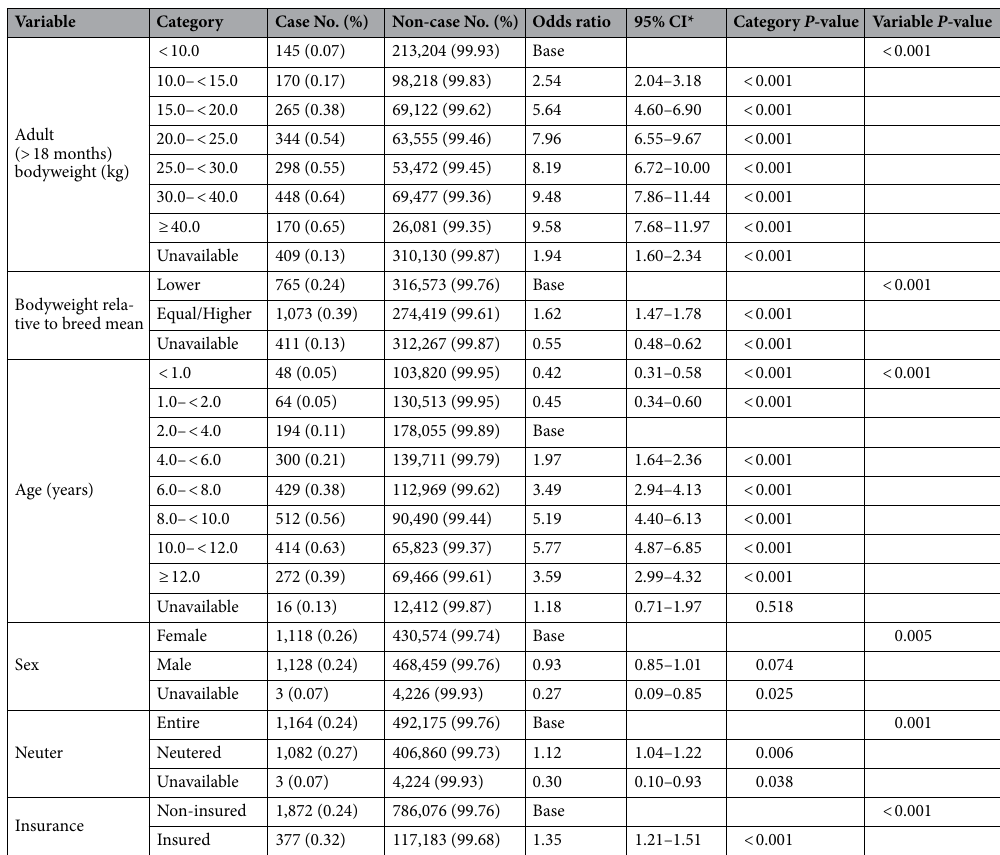
Table 3. Descriptive and univariable logistic regression results for non-breed-related demographic risk factors evaluated for aural haematoma during 2016 in dogs under primary veterinary care in the VetCompass™ Programme in the UK. Column percentages shown in brackets. *CI confidence